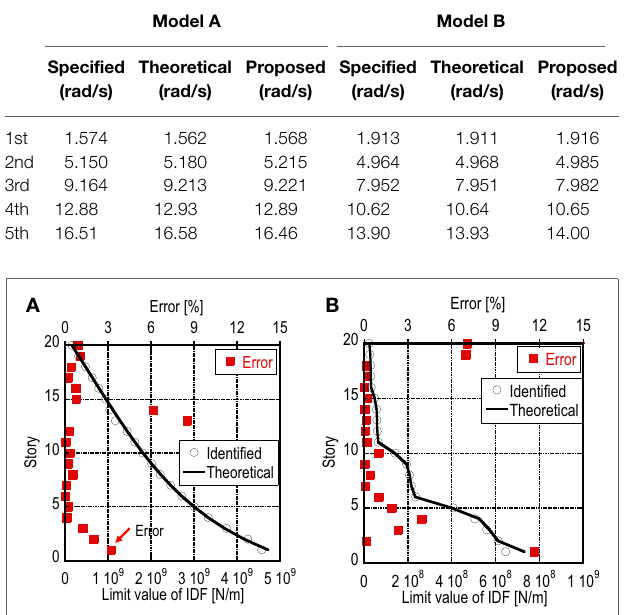
Frontiers in Built Environment |